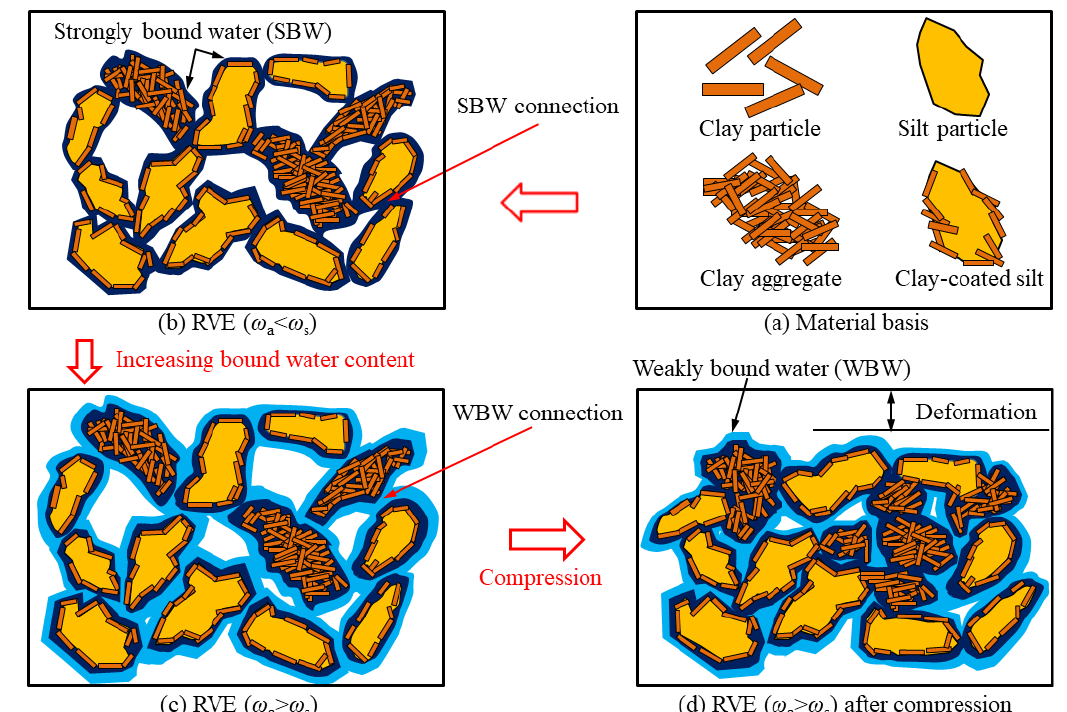
Figure 8. The four-tiered conceptual model for the particle–water system and uniaxial confined compression: ( a ) material basis; ( b ) RVE ( ω a < ω s ); ( c ) RVE ( ω a > ω s ); ( d ) RVE ( ω a > ω s ) after compression.